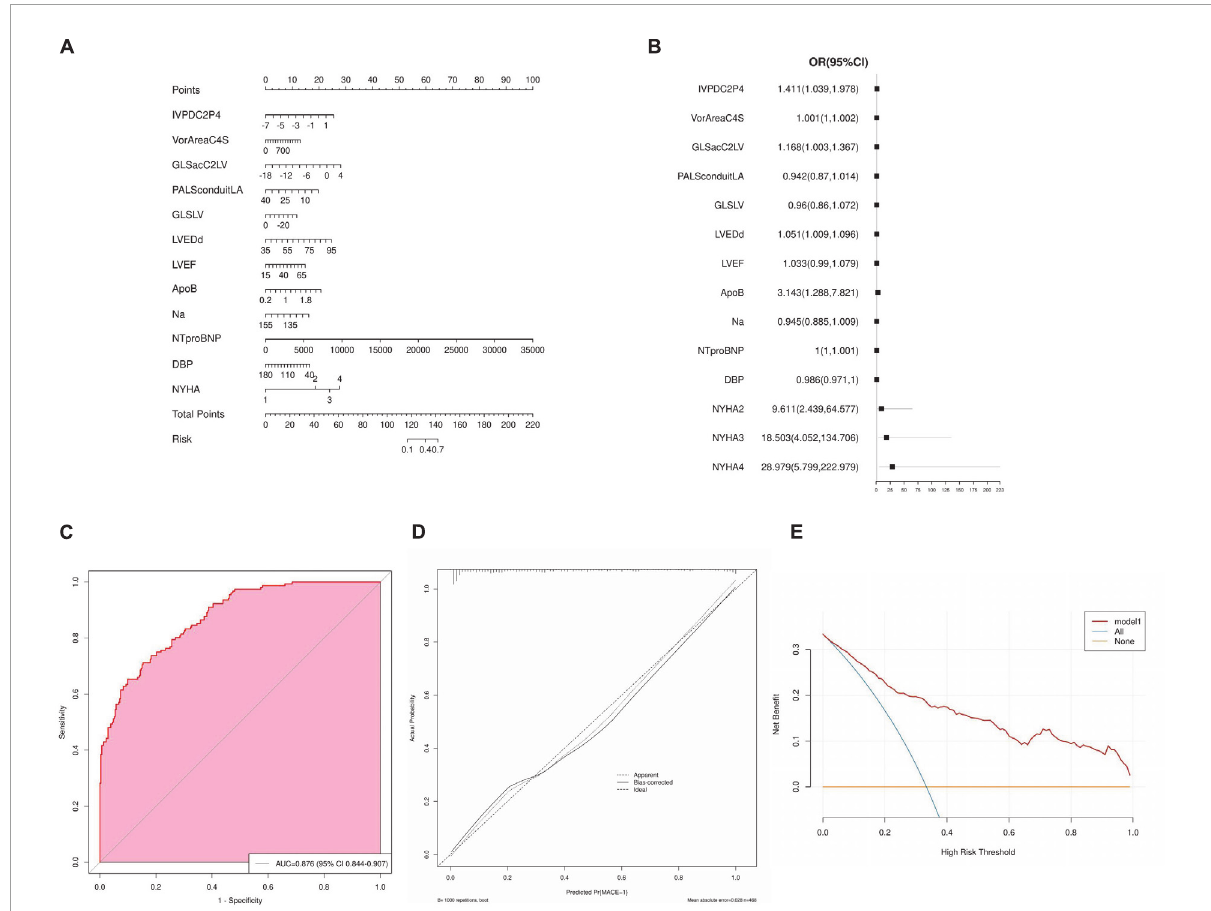
FIGURE5 Nomogram interpretation and model validation. (A) Nomogram for predicting major cardiovascular events (MACE) risk, and the point was the selected scoring standard or scale. (B) Odds ratios determined in a logistic regression model as shown in the forest plot. (C) Receiver operating characteristic curve for the nomogram. (D) The Nomogram calibration plots of the model. (E) Decision curve analysis for predictive models.